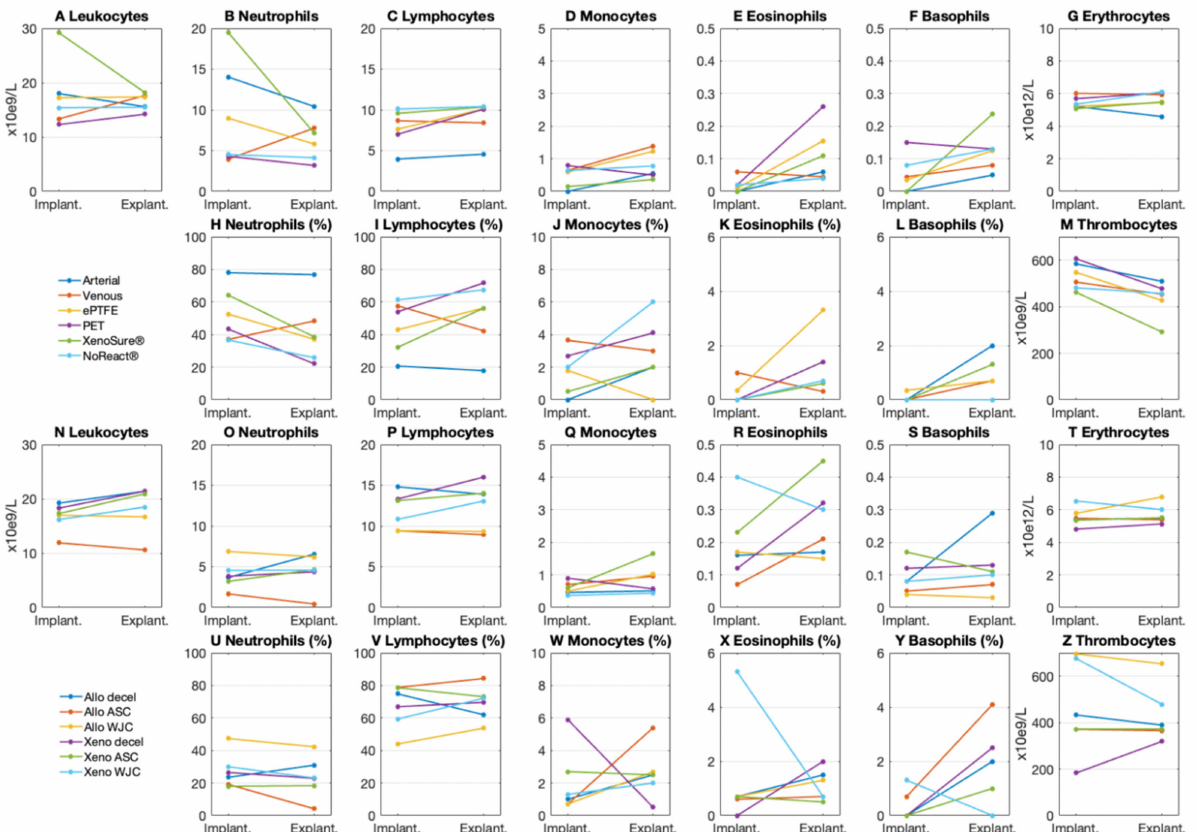
Figure 13. Blood counts in laboratory pigs implanted with ( A – M ) control and ( N – Z )